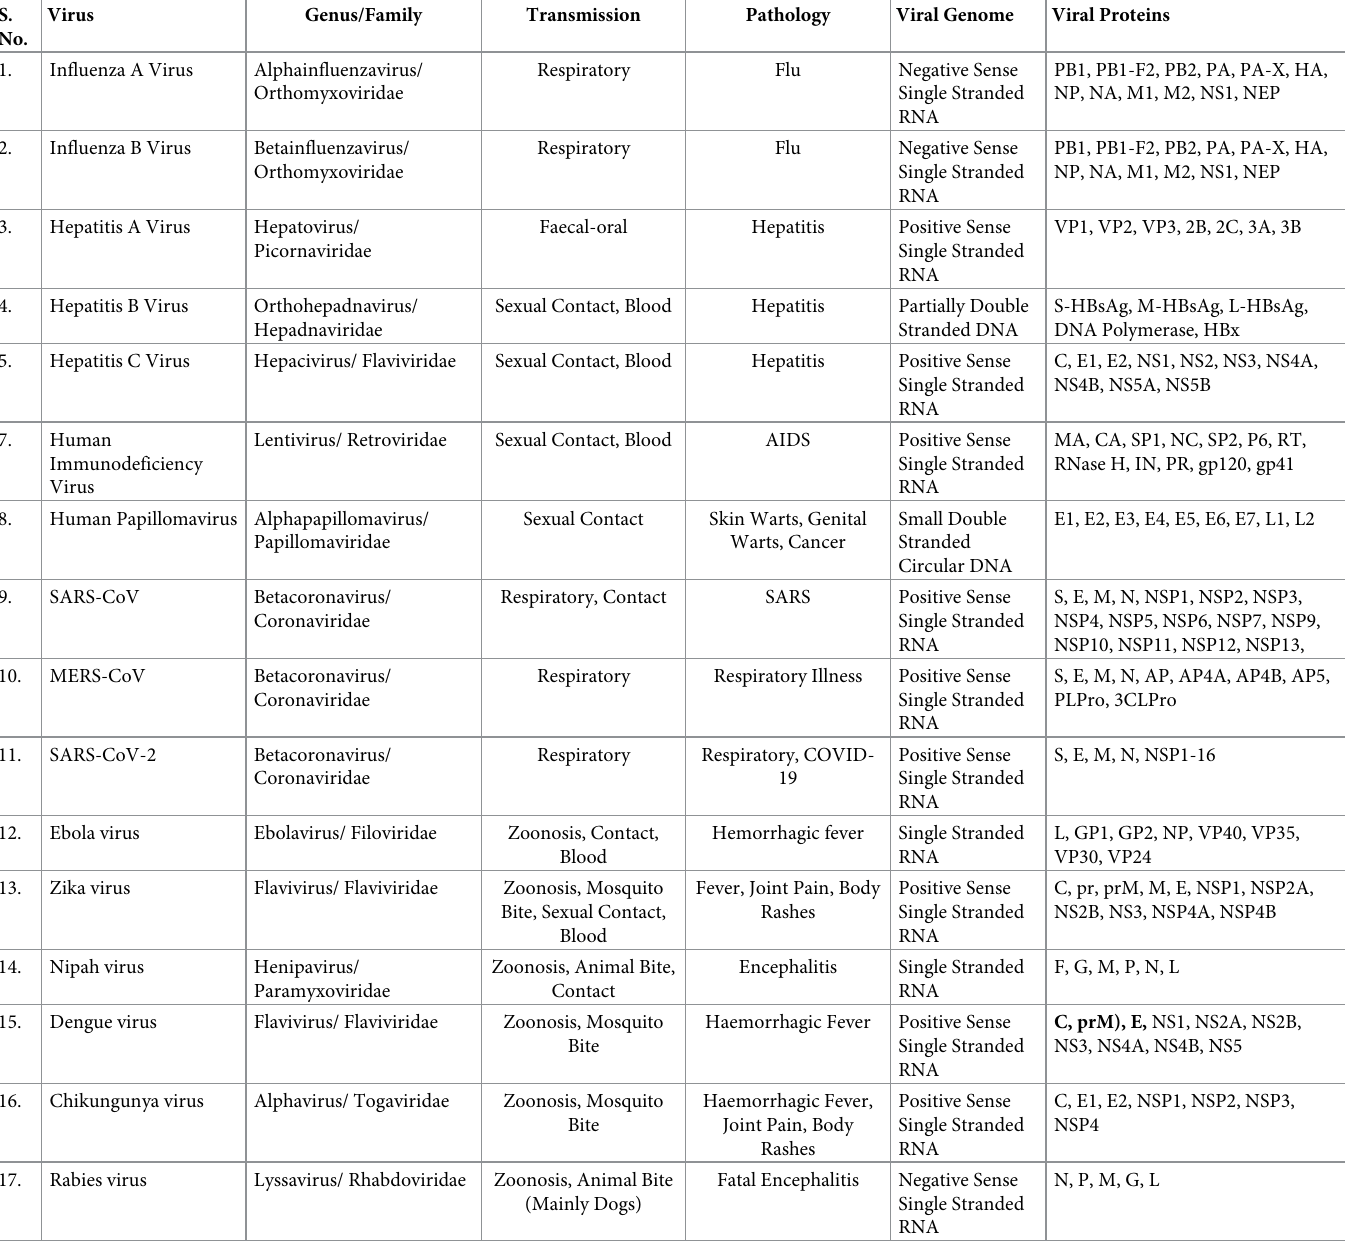
Table 1. An overview of the human viruses, their mode of transmission, pathogenesis, genome and viral proteins. S. No.